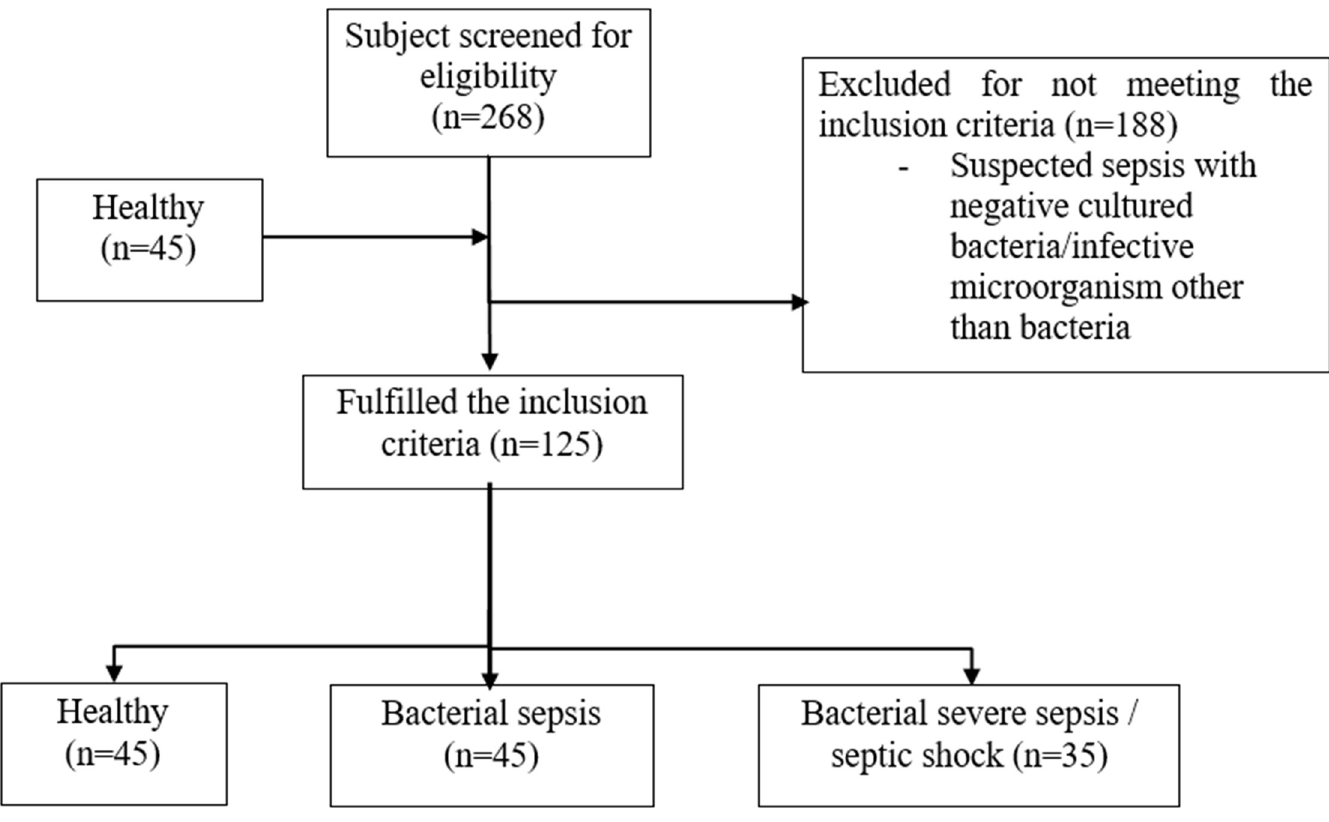
Fig 1. Recruitment of research